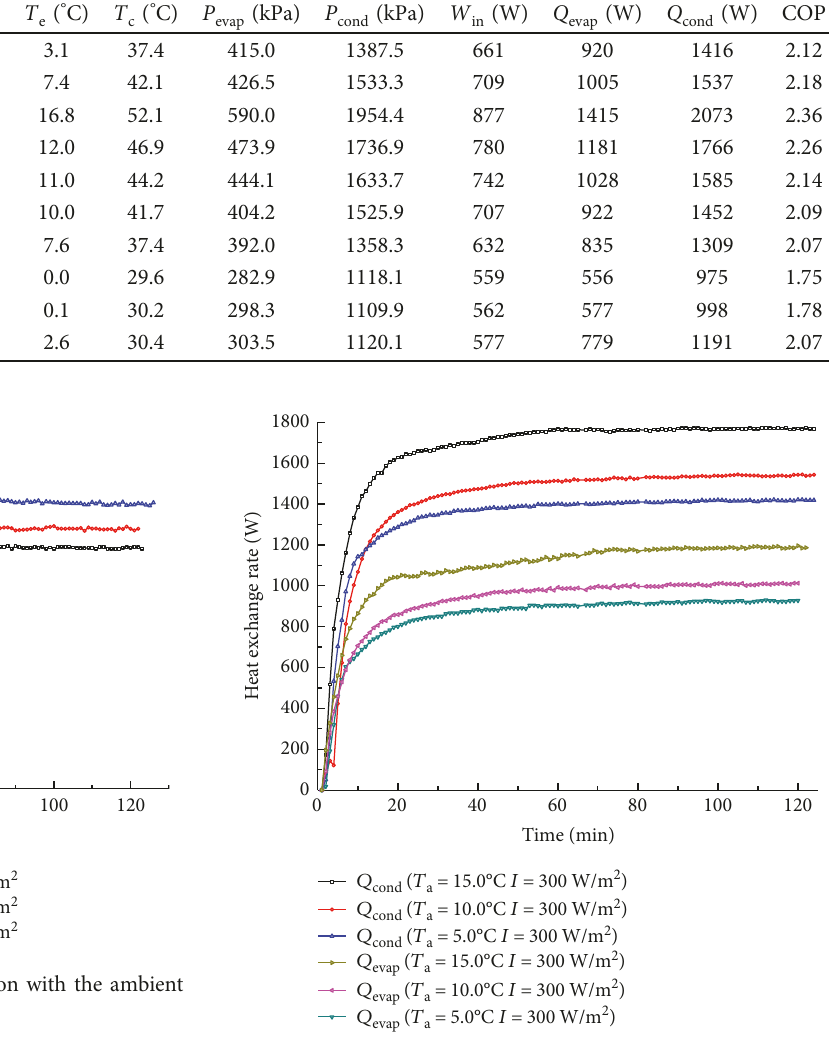
Figure 3: Variation of the evaporating and condensing heat exchange rate with the ambient temperature of 5 ° C, 10 ° C, and 15 ° 1.9%, 1.9%, and 1.8%) while the condensing heat exchange rates are 1416 W, 1537 W, and 1766 W with the ambient tem- perature of 5 ° C, 10 ° C, and 15 ° C.